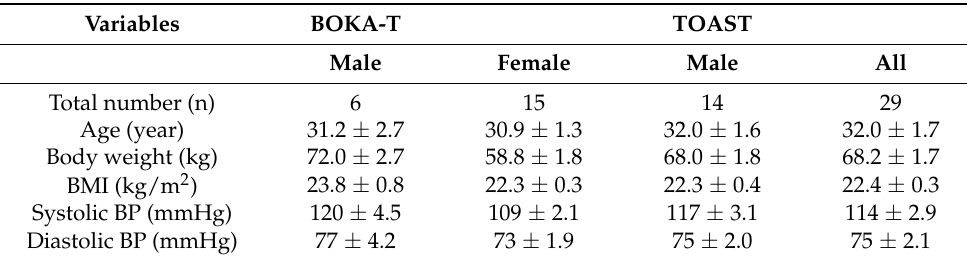
Table 1. Baseline clinical and demographic characteristics of participants for the BOKA-T and TOAST studies.